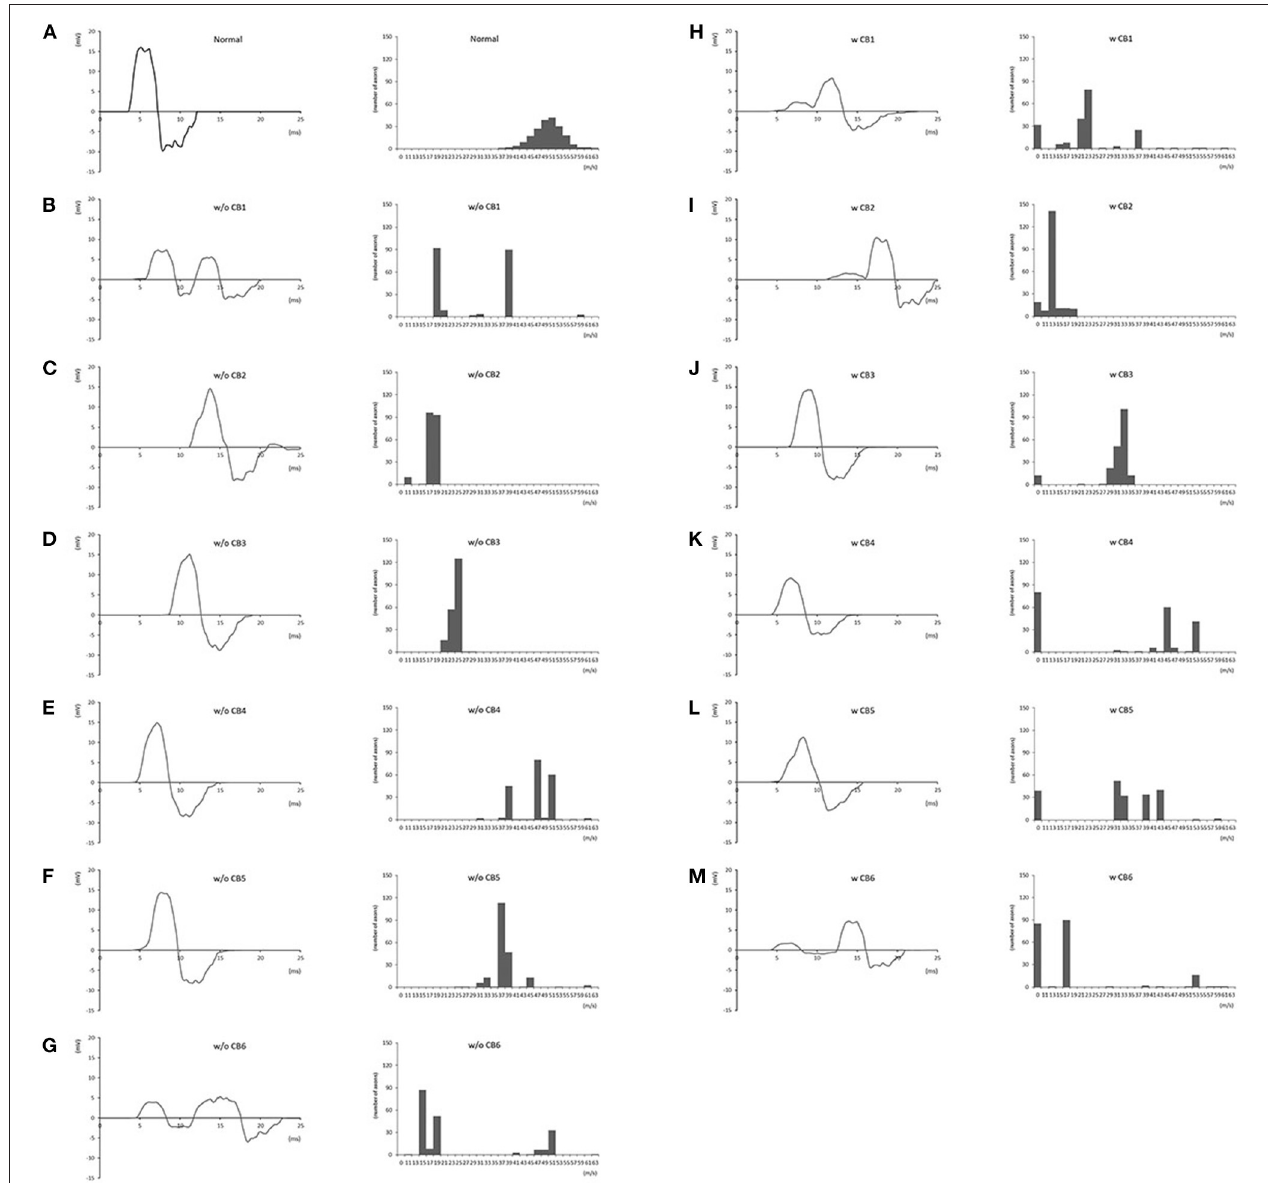
FIGURE 1 | Representative compound muscle action potential waveforms and conduction velocity histograms for each group. (A) : normal; (B) : w/o CB1; (C) : w/o CB2; (D) : w/o CB3; (E) : w/o CB4; (F) : w/o CB5; (G) : w/o CB6; (H) : w CB1; (I) : w CB2; (J) : w CB3; (K) : w CB4; (L) : w CB5; (M) : w CB6 (see Table 2 for group